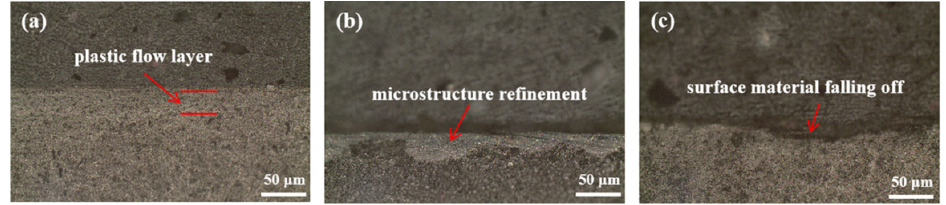
Figure 9. The cross-section of the worn morphology of shims after engine bench test (OM): ( a ) 350 h, ( b ) 700 h, ( c ) 1000 h.